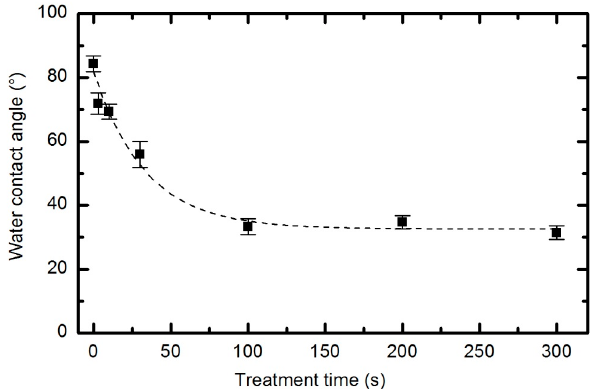
Figure 19. Water contact angle versus plasma treatment time at 33 Pa and 150 W.